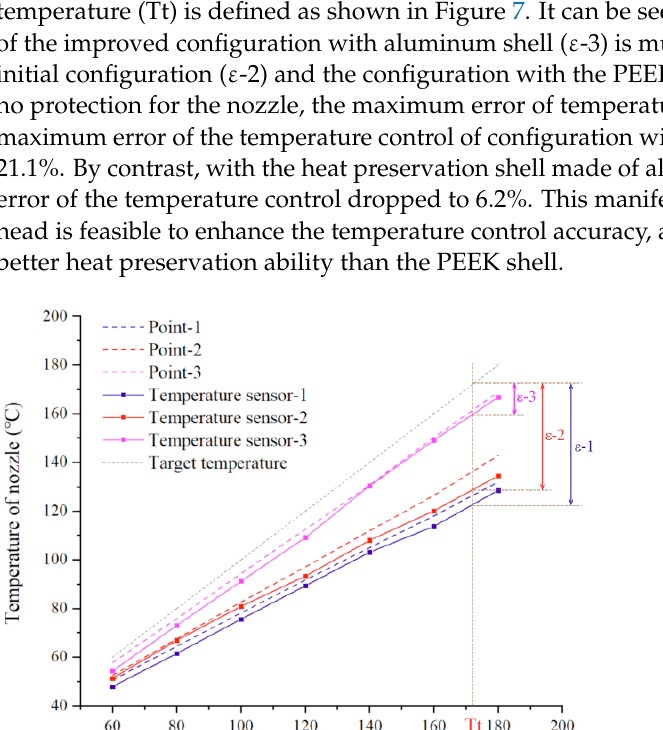
Figure 6. Experimental setup for the measurement of temperature.